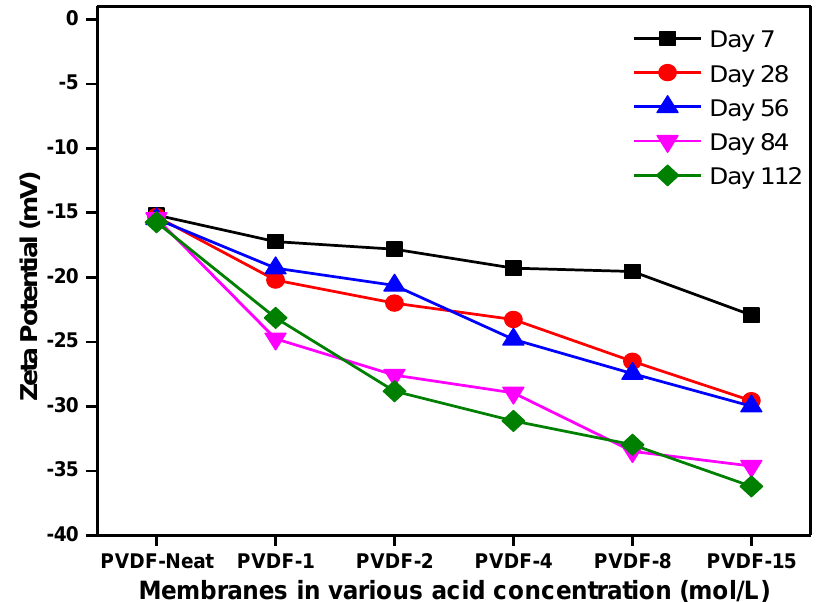
Figure 8. Surface zeta potential at di ff erent times of immersion of membranes embedded in varying sulfuric acid concentrations.